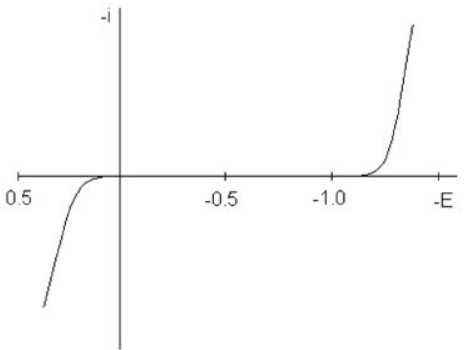
Figure 2. Polarization curve of the mercury electrode in 0,1 mol L –1 . HNO 3